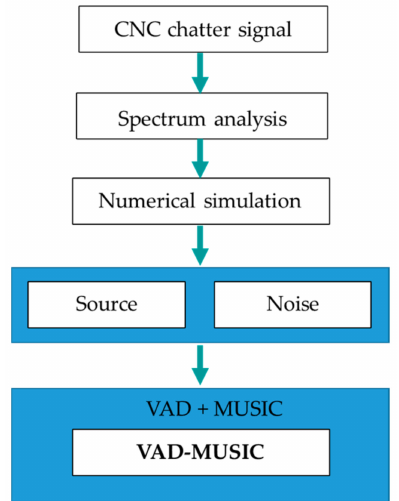
Figure 2. The structure of the proposed method for noise reduction of source direction